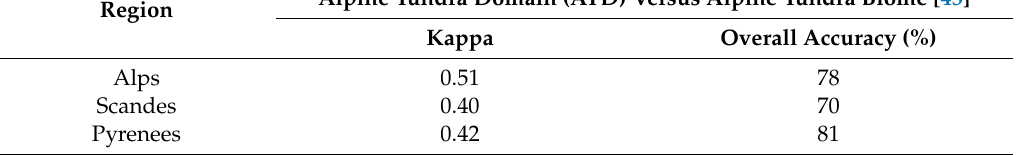
Table 3. Degree of agreement between the alpine tundra domain (ATD) mapped using WorldClim data (Version 1.4) at a 1-km grid size [48] versus the alpine tundra biome (alpine vegetation, subnival vegetation of high mountains and glaciers) according to Bohn et al. [45], using Cohen’s Kappa statistic and overall